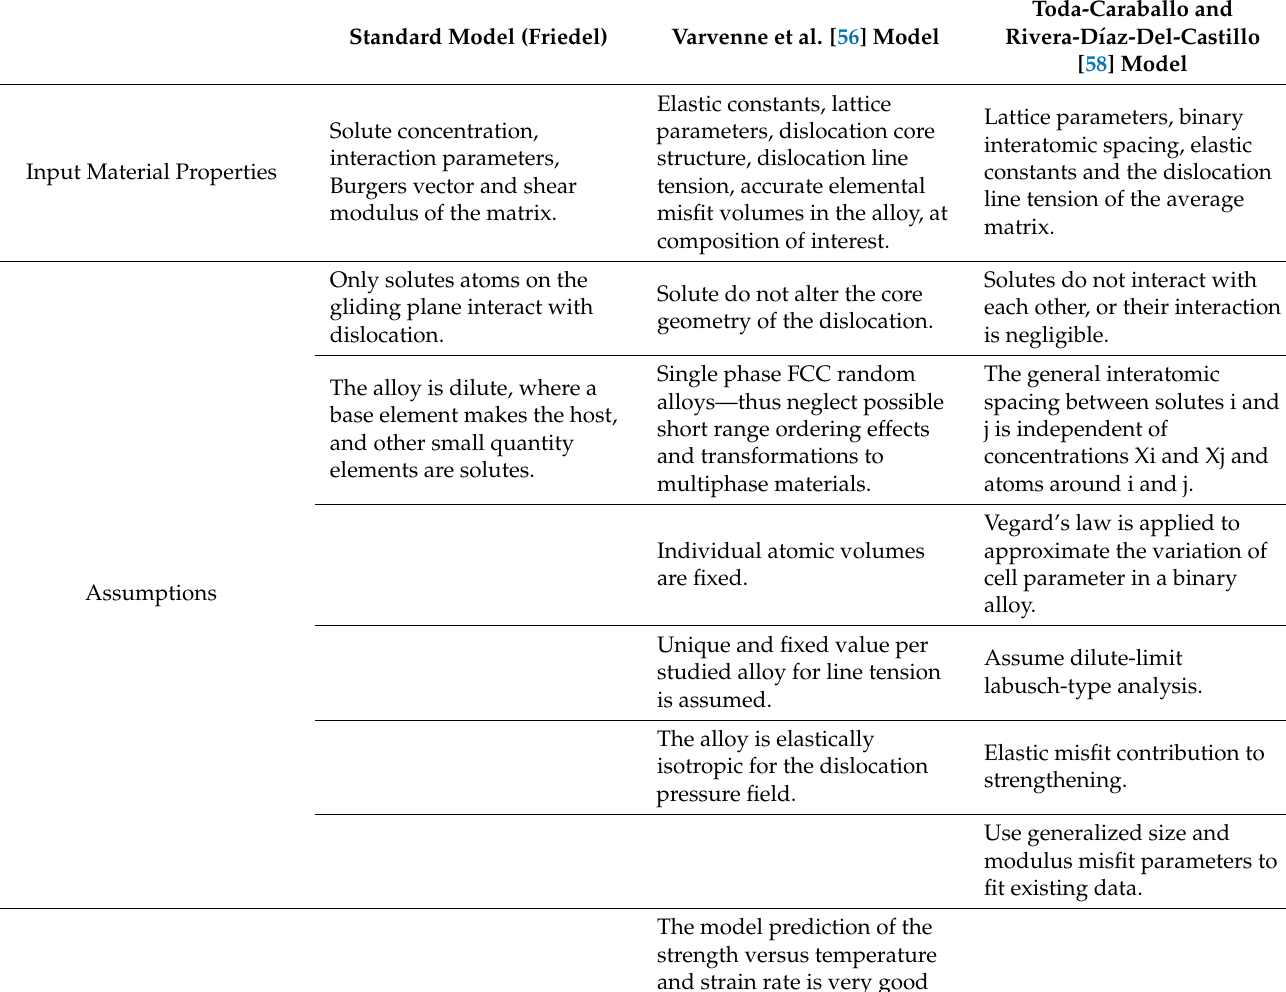
Table 1. Comparison of solid solution strengthening models in terms of their technical